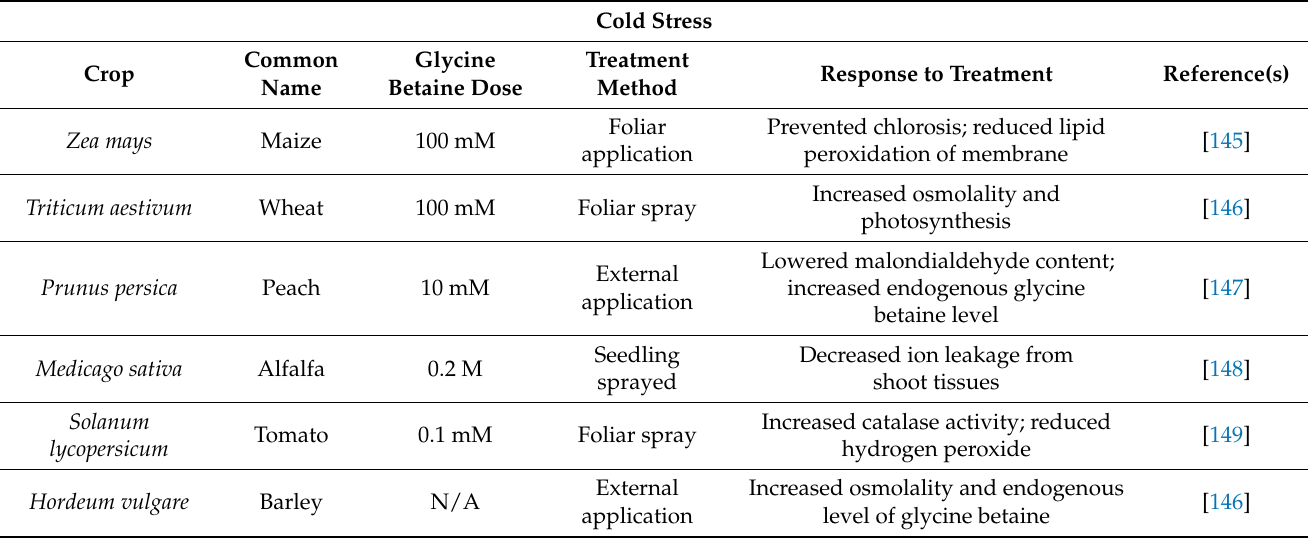
Table 19. Physiological responses of various crops to glycine betaine treatment against cold